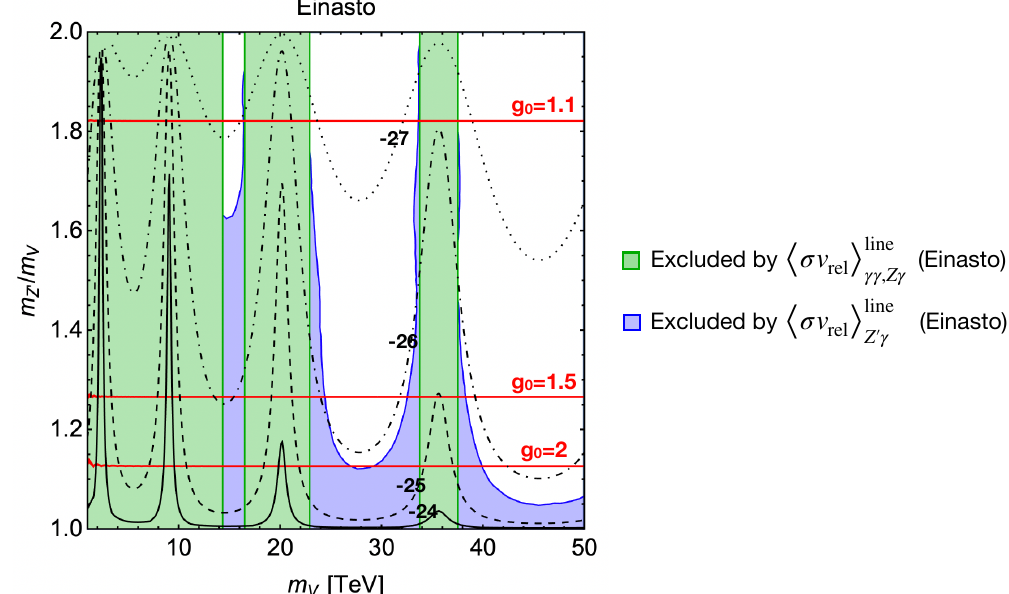
Figure 2 . The current bound on the line cross section by the H.E.S.S. observation for the Einasto profile [33]. The green regions are excluded by h σv . The black solid, dashed, dot-dashed, and dotted contours show the predicted value of h σv rel i line Z 0 γ for 10 − 24 , 10 − 25 , 10 − 26 , and 10 − 27 in the unit of cm 3 /s, respectively. The red solid lines h σv rel i line Z 0 γ show the g 0